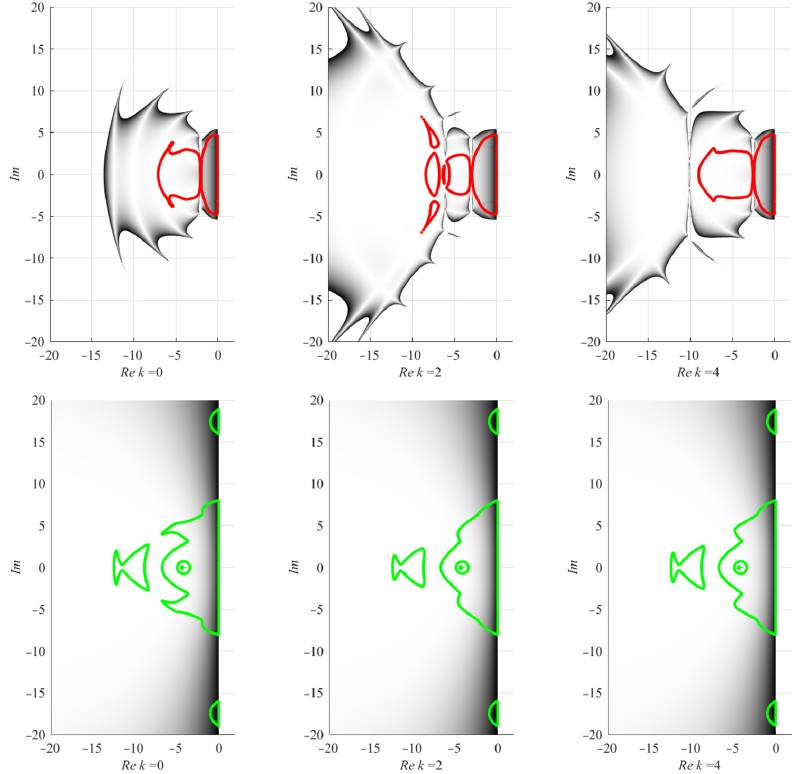
Figure 9. Stability regions of XB5 composition scheme using semi-implicit CD solver as a basic method.